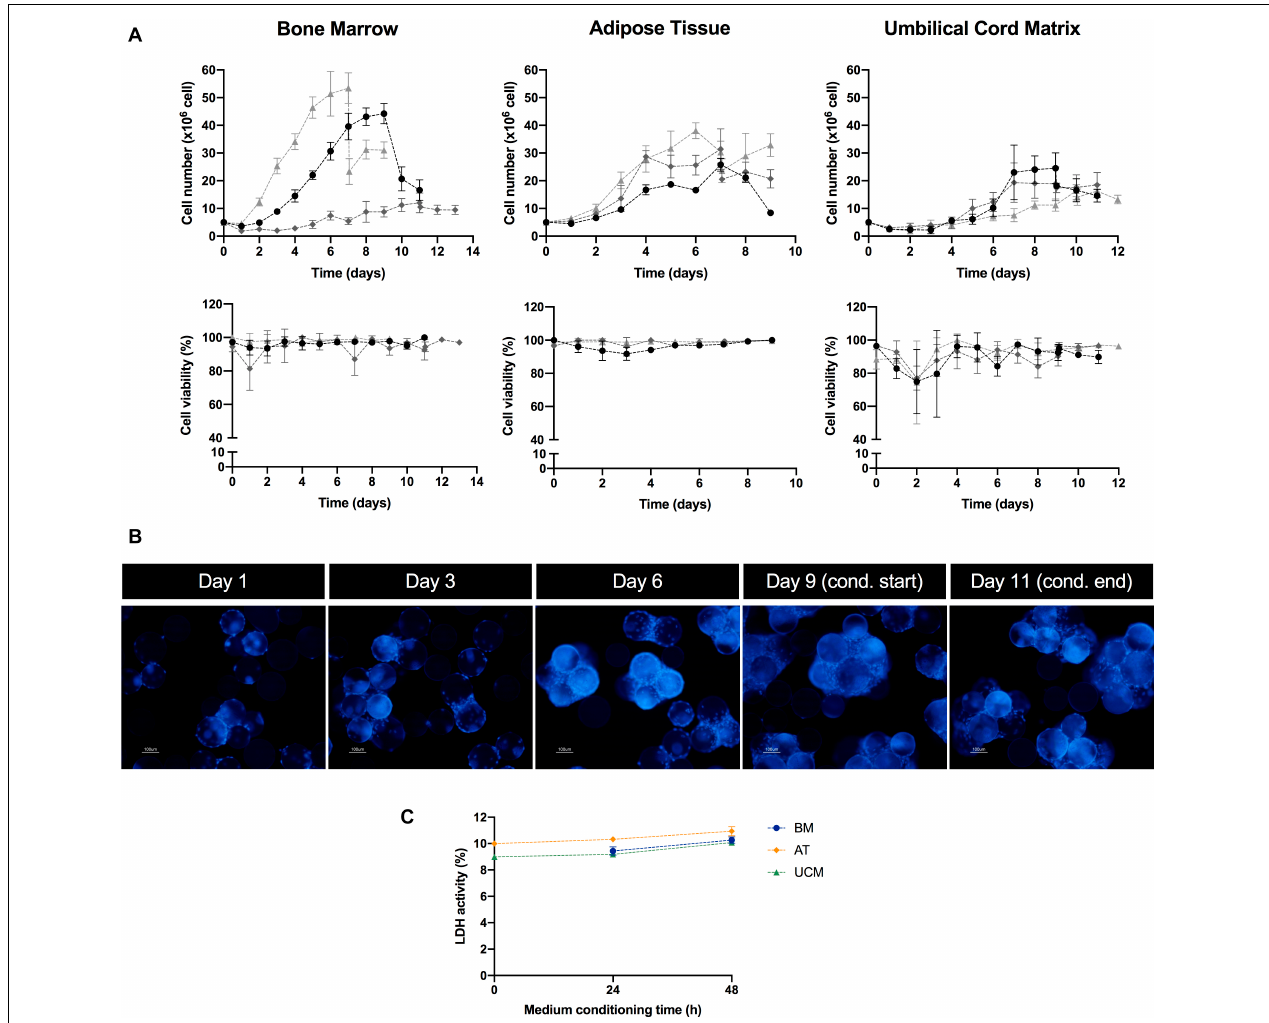
FIGURE 2 | MSC culture in the microcarrier-based bioreactor system. (A) Evolution of cell number (upper panel) and cell viability (lower panel) over culture period time, for MSC from three different human tissue sources (bone marrow, adipose tissue, and umbilical cord matrix). MSC from three different donors (i.e., three biological replicates) were used per tissue source, which are represented in three different shades of gray. Two data points are presented for the same day when the medium conditioning stage (i.e., EV production) started. Results are presented as mean ± SD of cell count for each time point. (B) Representative images of microcarrier occupation by MSC throughout culture. Cell nuclei were stained with DAPI and images were acquired using a fluorescence microscope. In this case, EV production started on day 9 of culture and finished on day 11. Scale bar = 100 µ m. (C) LDH activity profile during the medium conditioning (i.e., EV production) stage in the VWBR system. Culture medium samples were taken at 0, 24, and 48 h after medium conditioning started. Results from one experiment for each MSC source (BM, AT, and UCM). Results are presented as mean ± SD ( n = 3). LDH, lactate dehydrogenase; VWBR, Vertical-WheelTM bioreactor; BM, bone marrow; AT, adipose tissue; UCM, umbilical cord